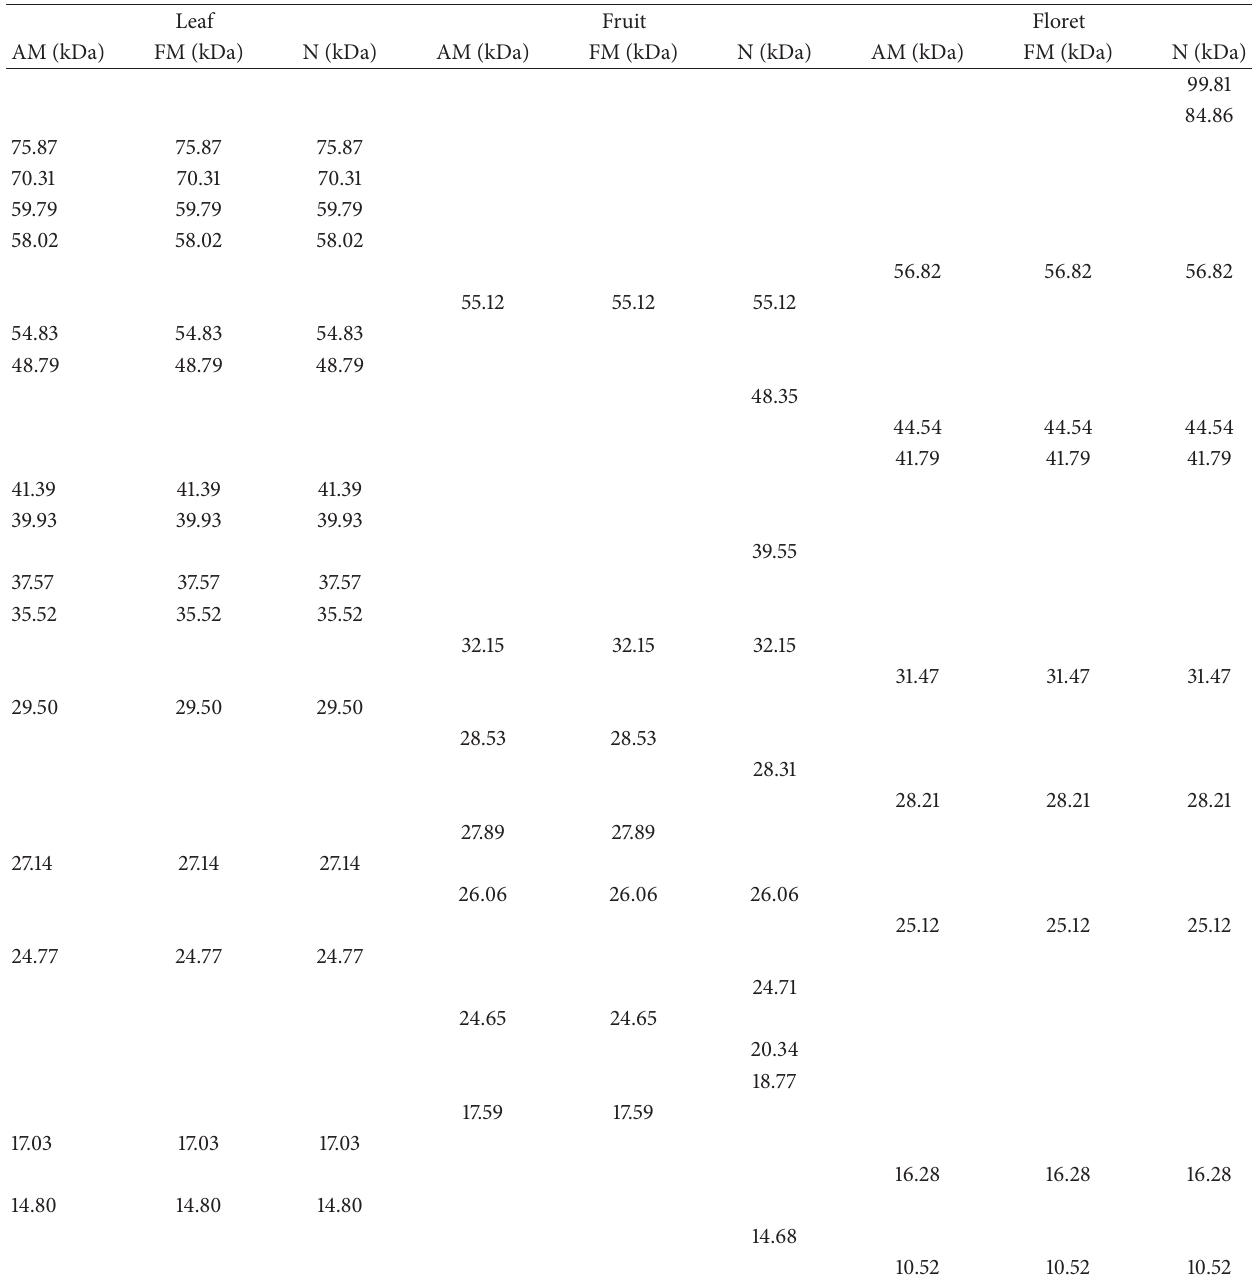
Table 1: Estimated molecular size of protein fragments of 100% abortive mantled, 50% fertile mantled, and phenotypically normal samples (leaf, fruit, and floret). Leaf Fruit Floret AM (kDa)